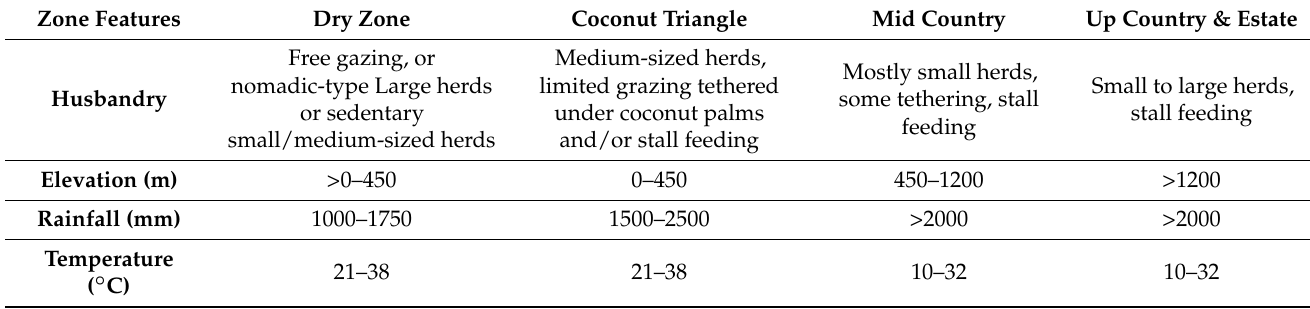
Table 1. Milk production zones in Sri Lanka (after [23]).